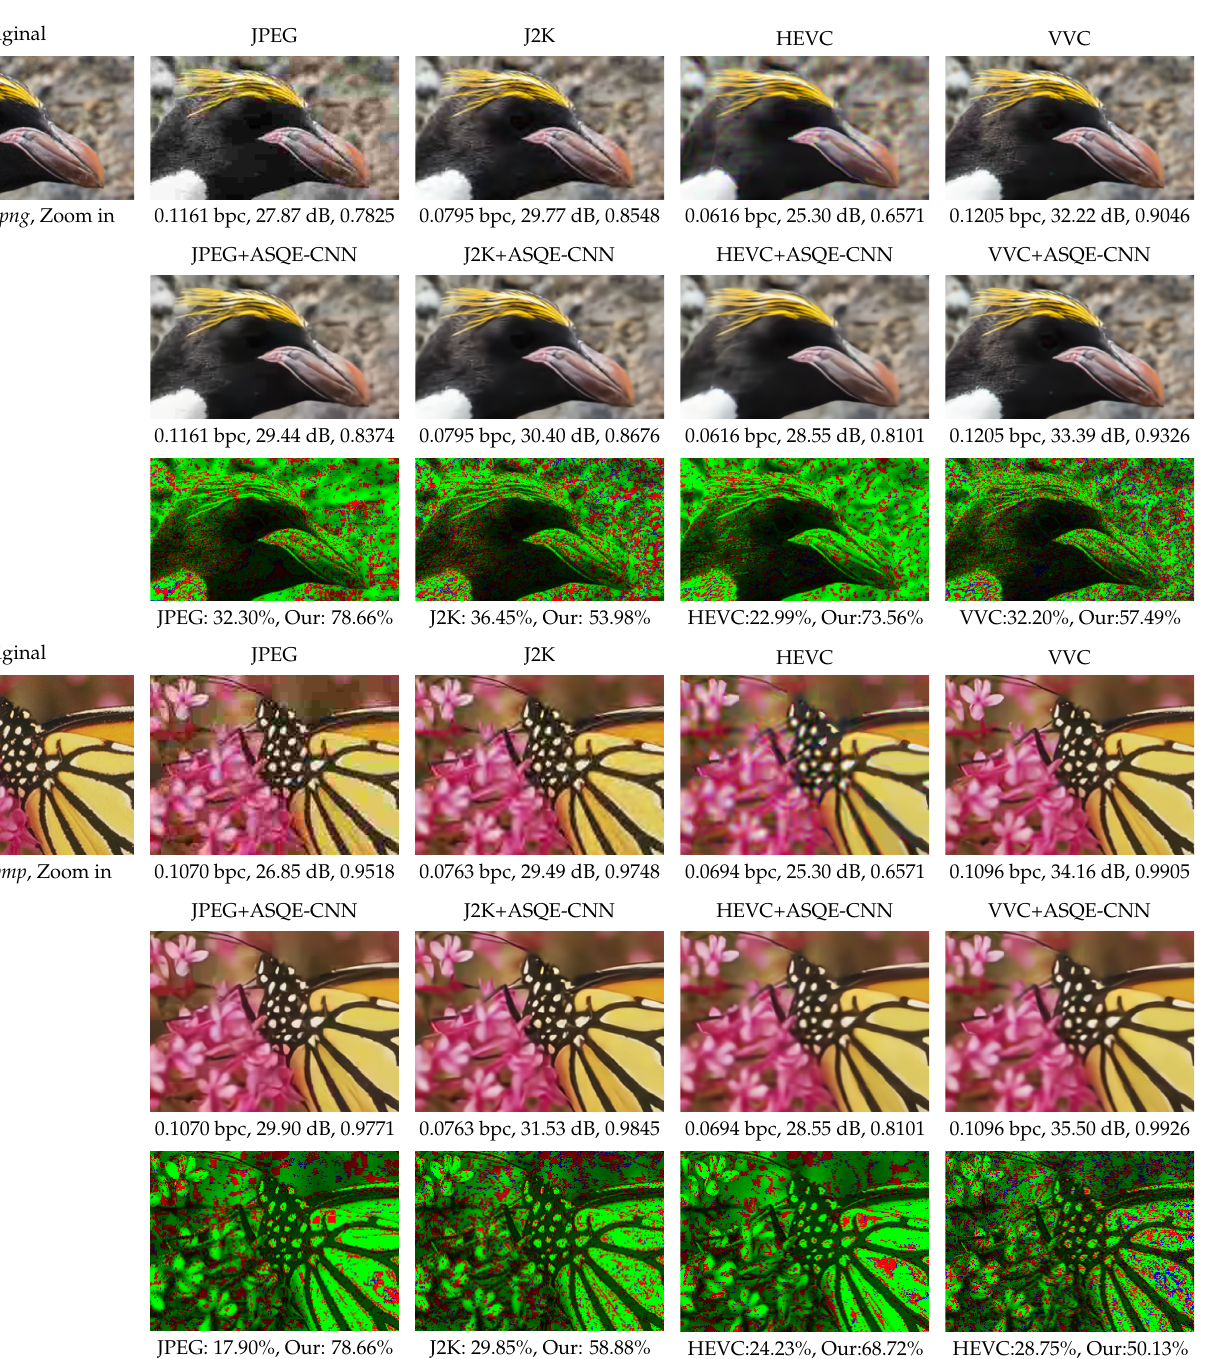
Figure 8. Visual results for images 801.png from DIV2K_valid_HR [52] and 15.bmp from LIVE1 [54]. (1st and 4th row) Original image and visual results of image and video codecs, JPEG [1], J2K [2], HEVC [3], and VVC [47]. (2nd and 5th row) Quality enhancement results corresponding to each codec. (3rd and 6th row) Pseudo-colored image comparison. Green marks the pixel positions where ASQE- CNN achieves better performance. Blue marks the pixel positions where the methods have the same performance. Red marks the pixel positions where the image/video codec (JPEG/J2K/HEVC/VVC) achieves better